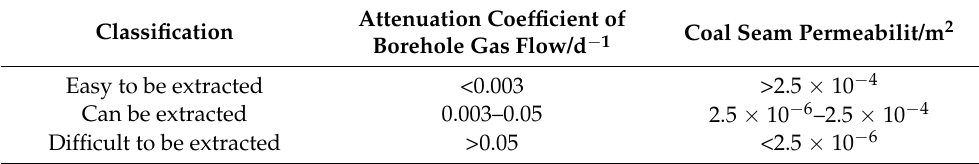
Figure 3. Location of Changcun Coal Mine and roadway layout of 2302 working face. Table 1. Difficulty degree of coal seam gas drainage.